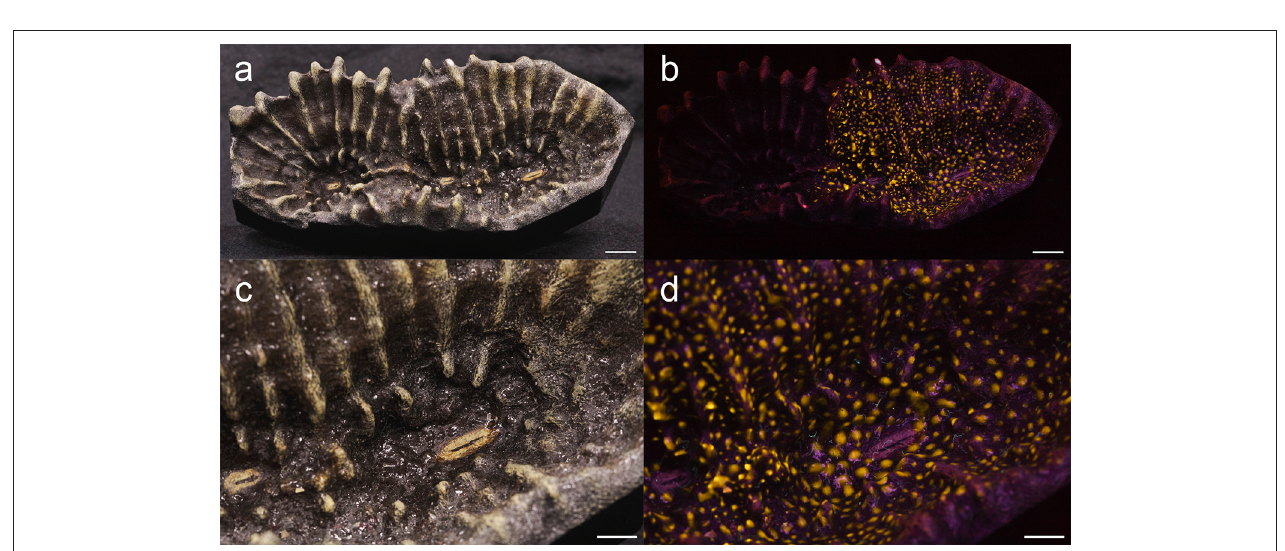
FIGURE 8 | Multi-spectral print of Oulophyllia crispa corallites. (a) Sandstone print of corallites texturised with model paint and UV reactive varnish under normal lighting. (b) Sandstone print of corallites texturised with model paint and UV reactive varnish under UV lighting. Scale bars represent 1cm. (c) Close-up of sandstone print of corallites texturised with model paint and UV reactive varnish under normal lighting. (d) Close-up of sandstone print of corallites texturised with model paint and UV reactive varnish under UV lighting. Scale bars represent